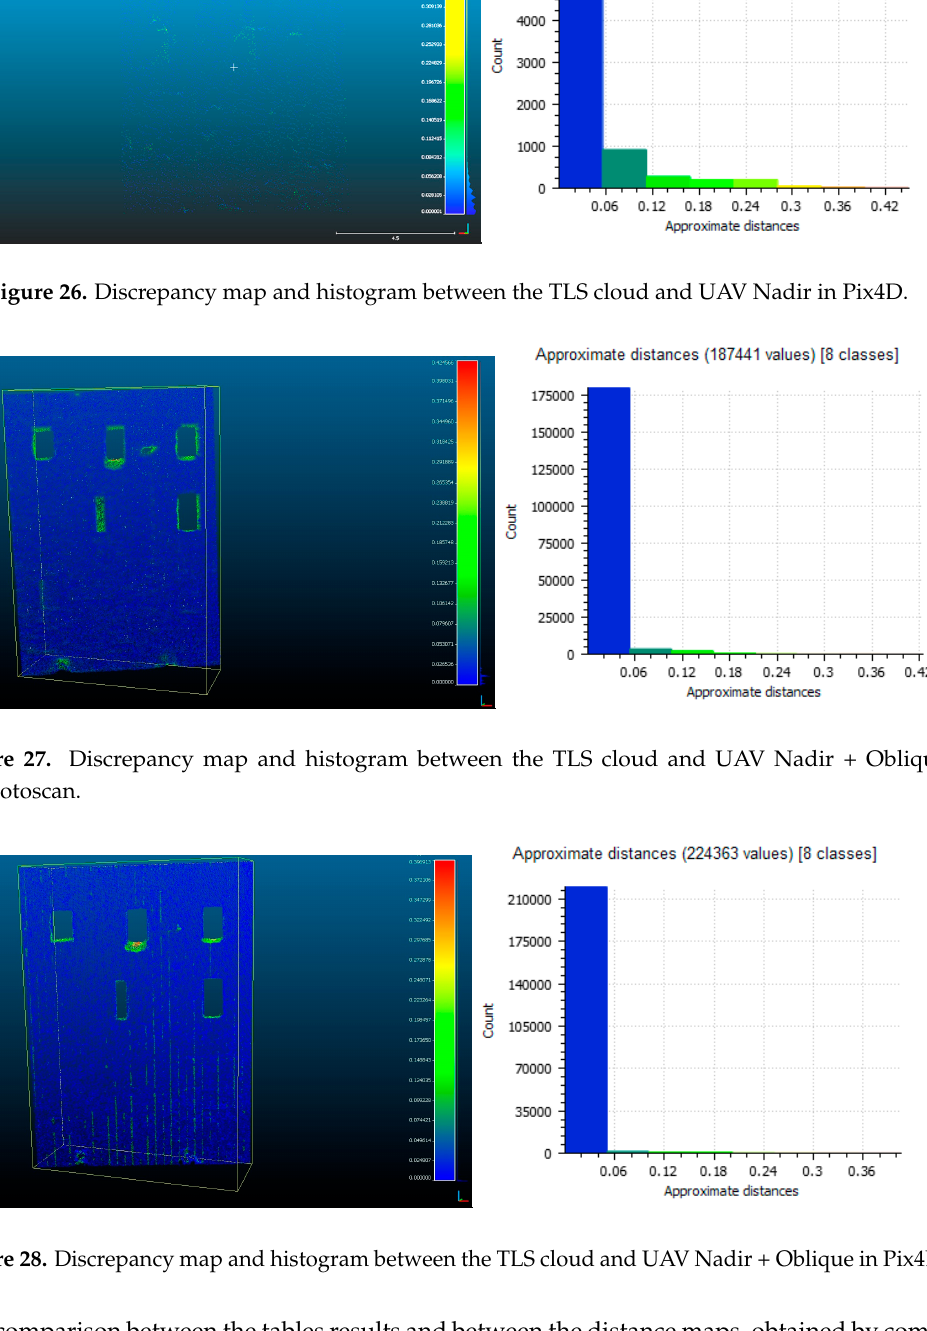
Figure 25. Discrepancy map and histogram between the TLS cloud and UAV Nadir in Photoscan.